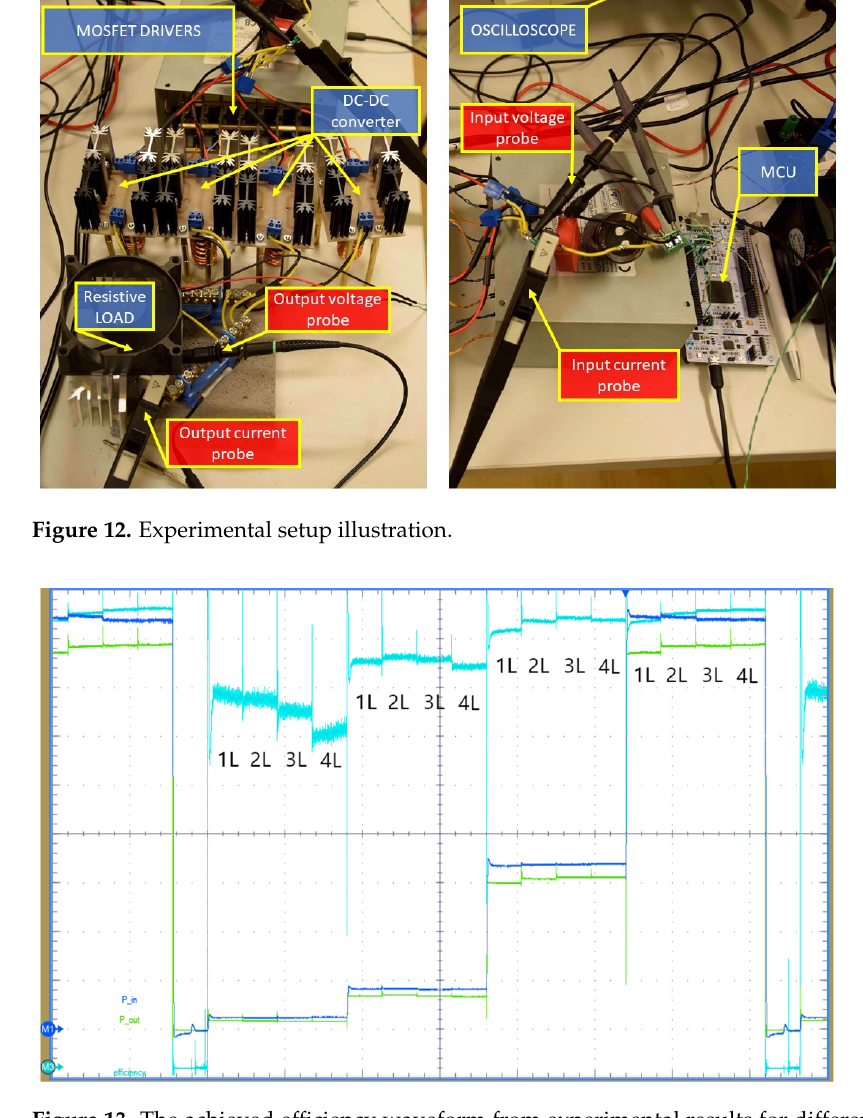
Figure 13. The achieved efficiency waveform from experimental results for different input power values as well as different converter legs number. The input power (darker blue) and the output power (green) waveforms have 12 W/div and the efficiency waveform (light blue) has 10%/div. The time base is 20 ms/div.